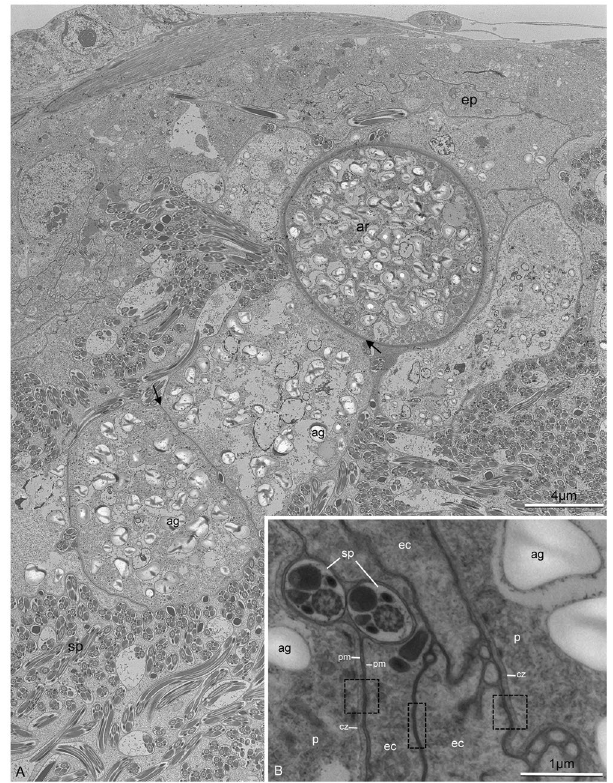
Figure 2. Electron micrographs of contaminated seminal vesicle of T. castaneum . ( A ) Segmented trophozoite with the anterior region (ar) inserted into the seminal vesicle epithelium (ep). Note the many amylopectin granules (ag) in all segments (arrows). Spermatozoa (sp). ( B ) Intimate association between the plasma membrane (pm) of the parasite (p) and plasma membrane of epithelial cells (ec). Note the junction between two epithelial cells (rectangle), and junctions between epithelial and parasitic membranes (squares). Cortical zone of the parasite